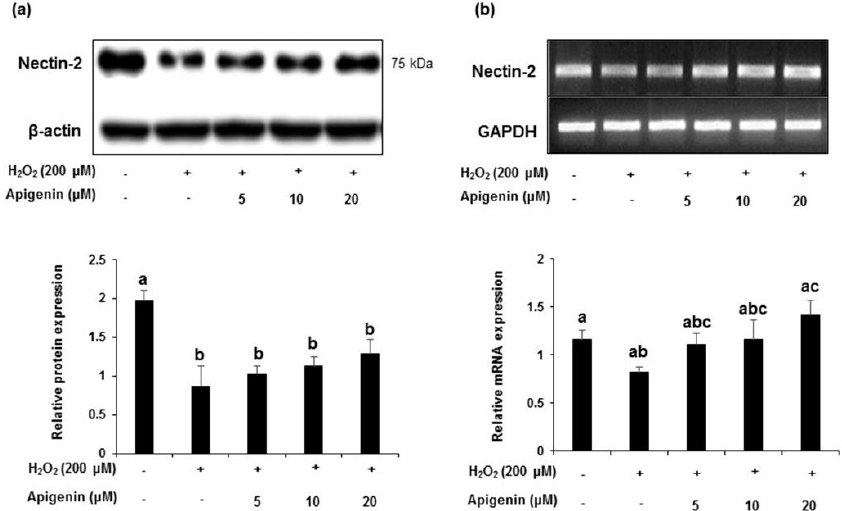
Figure 6. The effect of apigenin on the expression level of nectin-2 in H 2 O 2 -exposed GC-2spd cells. ( a ) The protein expression level of nectin-2 was analyzed using Western blotting. Cell lysates were immunoblotted with specific antibodies with Beta-actin as the internal control (upper panel) and the band intensity of nectin-2 normalized to β -actin is shown in corresponding lower panel. ( b ) The mRNA expression of nectin-2 (upper panel) and corresponding band intensities normalized to GAPDH (lower panel). Data are expressed as the mean ± standard deviation. The groups of control, H 2 O 2 , and different concentrations of apigenin were compared with each other and letters on the top of the columns that do not share the same letters are statistically significant among the groups ( p < 0.05) by one-way ANOVA.